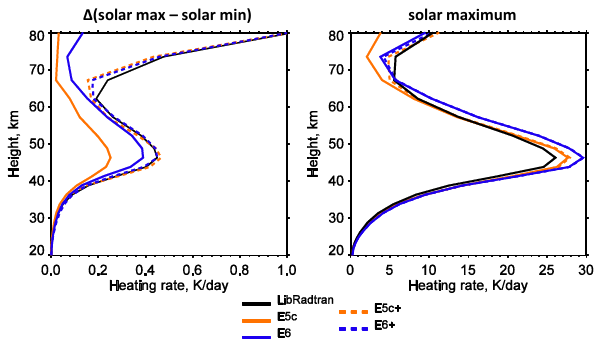
Figure 5. Shortwave heating rates in Kday − 1 for tropical stan- dard atmosphere and solar zenith angle equal to 10 ◦ . Left panel: differences between minimum and maximum (max-min) of the 11- year solar cycle in the case of UV only variability and a constant ozone profile. Right panel: absolute values during solar maximum. Coloured solid lines: results from original E5c and E6 codes. Black solid line: libRadtran results for reference. Dashed lines: results from improved parameterizations.